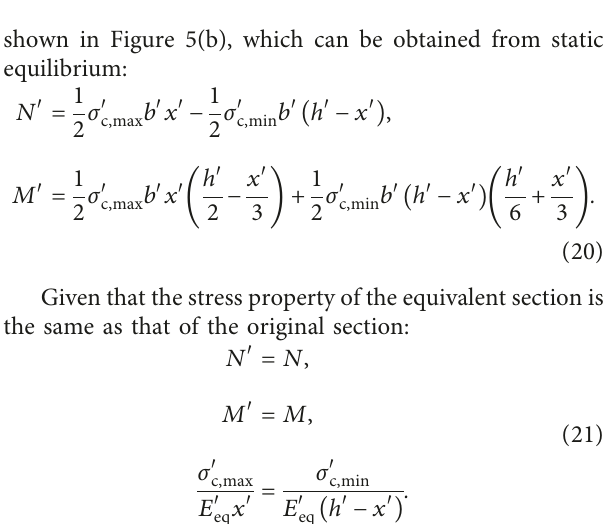
Figure 4: Analysis of the equivalent elastic modulus on the joint